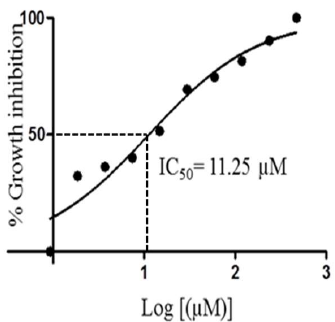
Figure 5. IC 50 curve for compound 1 when tested against Trypanosoma brucei brucei .